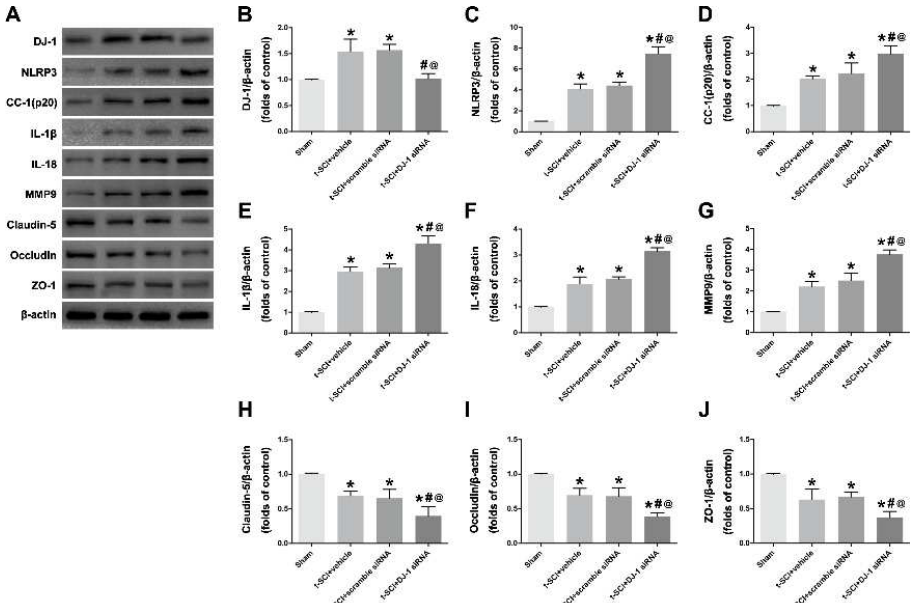
Figure 3. Downregulation of DJ-1 increased NLRP3 inflammasome activation and destruction of BCSB. ( A – G ): Representative Western blotting images and quantitative analyses of DJ-1, NLRP3, cleaved caspase 1 (CC-1), IL-1β, IL-18 and MMP9 expression at 24 h post-injury. ( H – J ): Representative Western blotting images and quantitative analyses of tight junction proteins including Claudin-5, Occludin and ZO-1 at 24 h post-injury. n = 6 for each group. * p < 0.05 vs. sham; # p < 0.05 vs. t-SCI + vehicle; @ p < 0.05 vs. t-SCI + scramble siRNA.